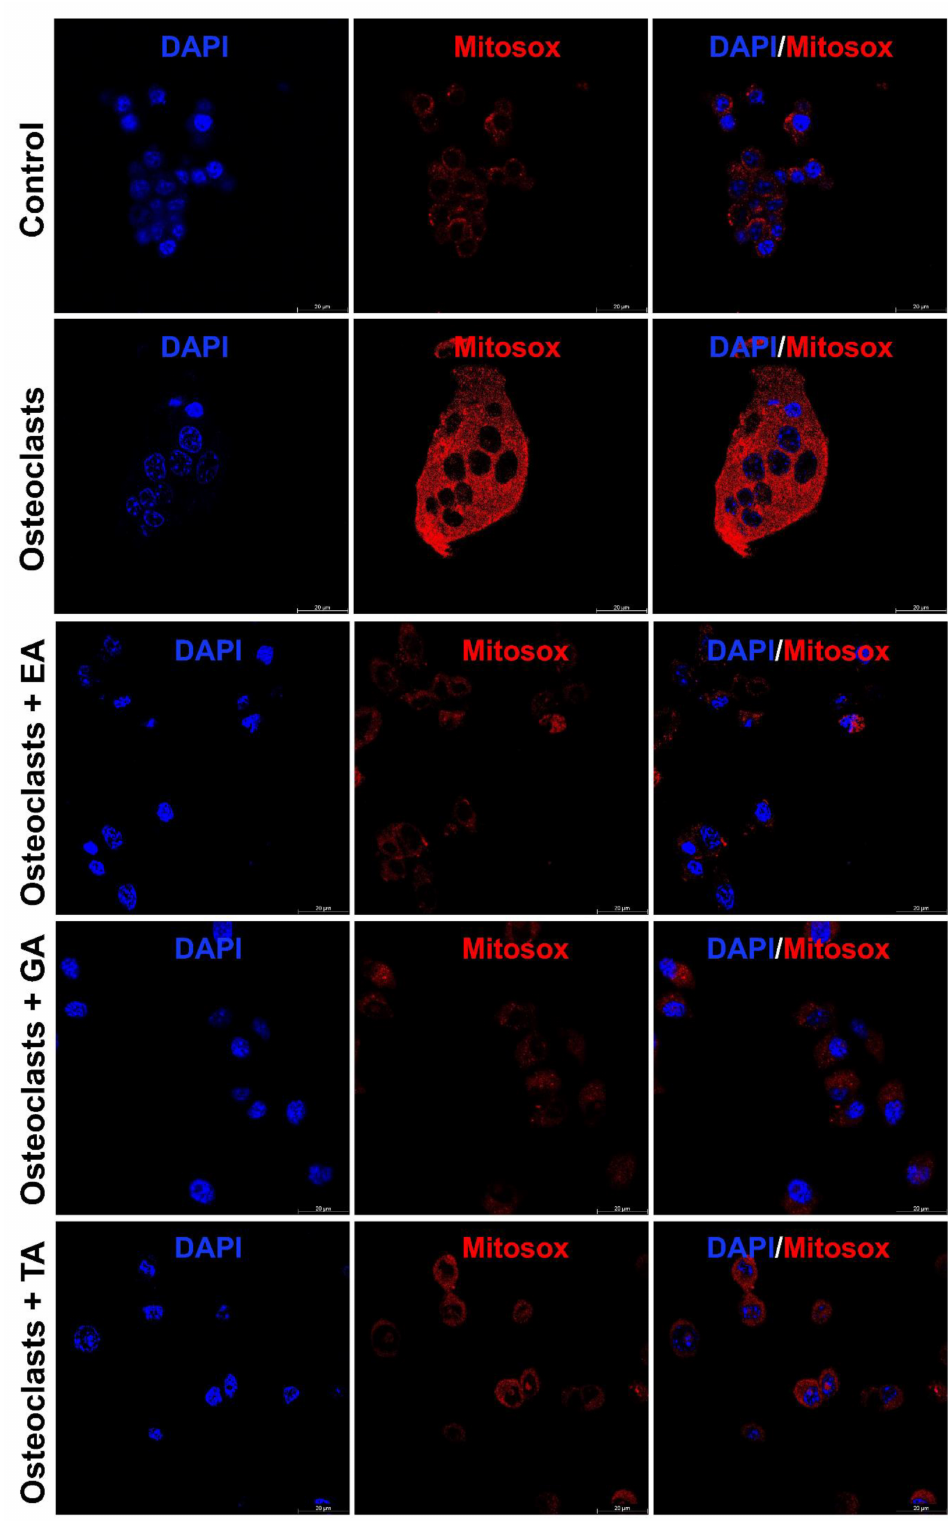
Figure 6. Polyphenolic compounds reduce mitochondrial superoxide production during osteoclast differentiation. Evaluation of mitochondrial superoxide production levels was shown by mitoSOX staining on day 6 in the absence or presence of ellagic acid (EA), gallic acid (GA), or tannic acid (TA) during osteoclast